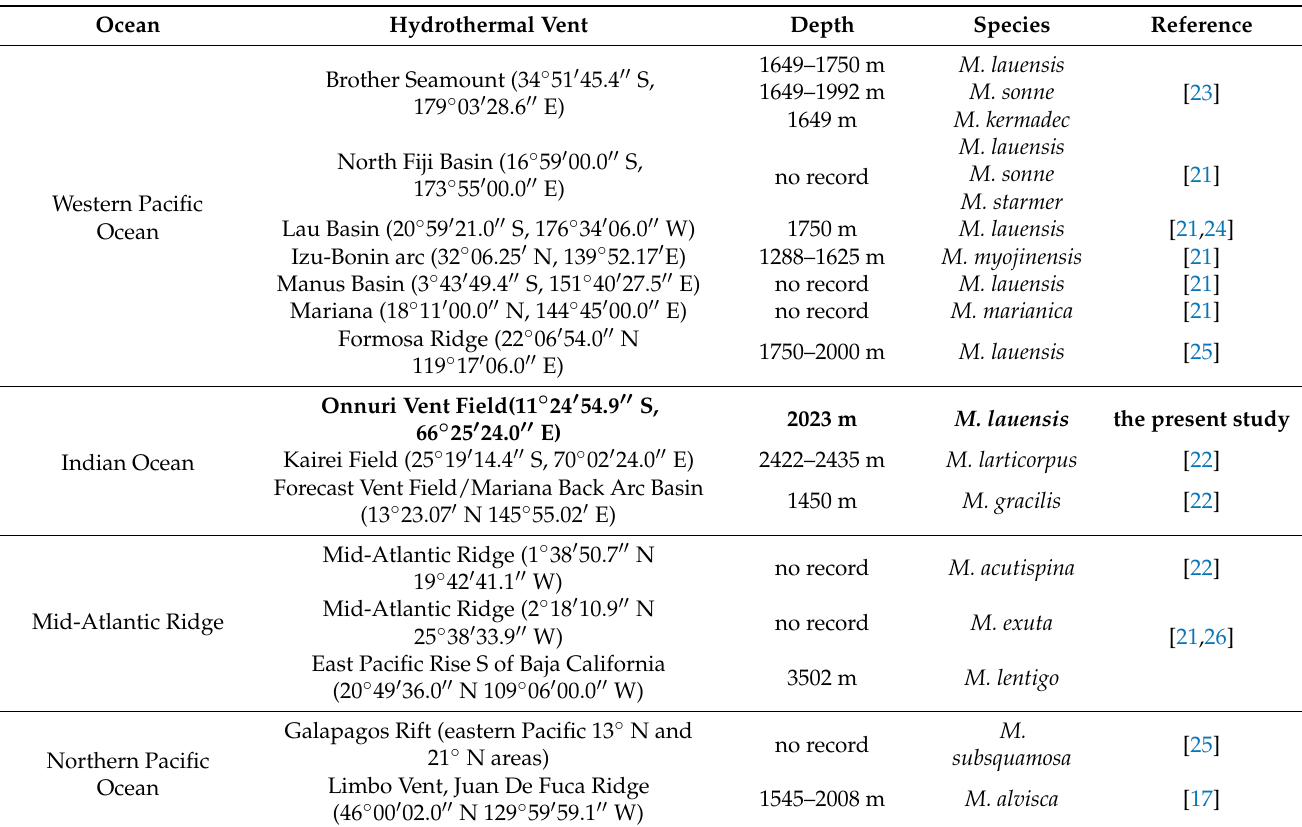
Table 1. Diversity of Munidopsis in hydrothermal